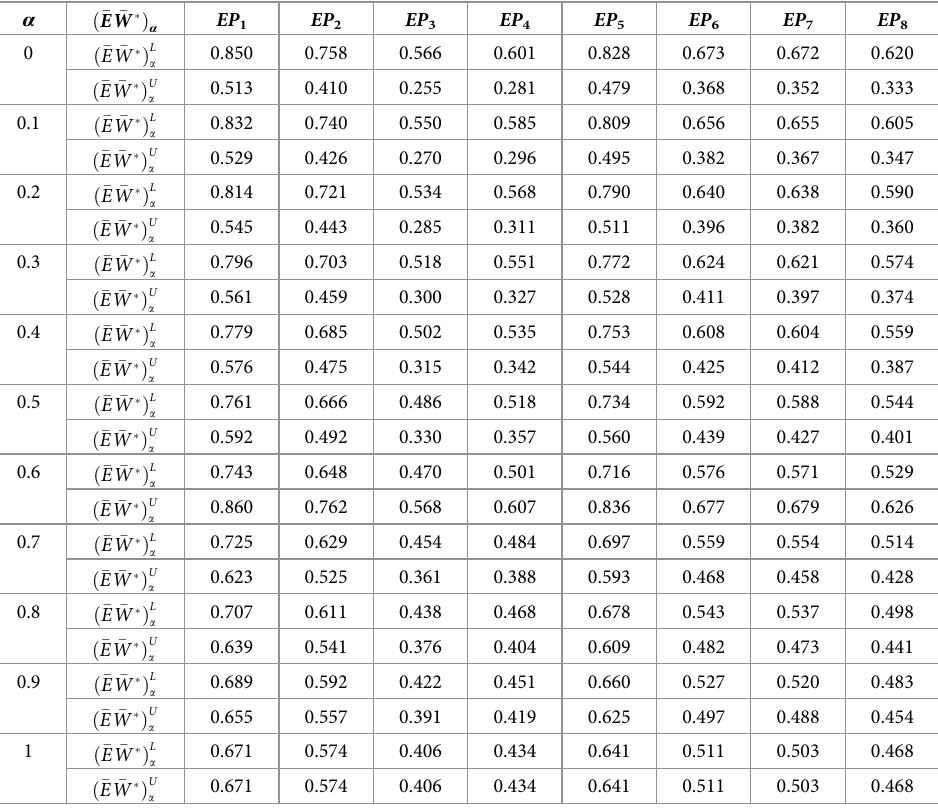
Table 12. The importance under α cut-set (taking DT as an example).